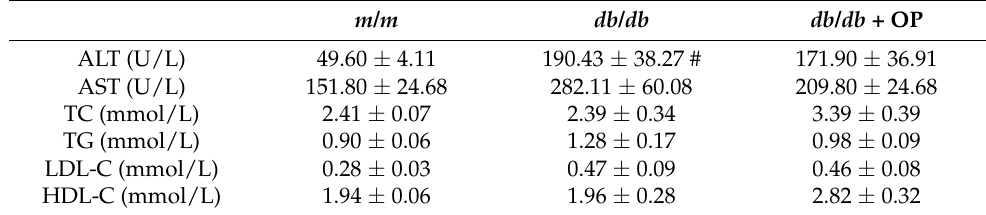
Table 2. The effects of OP on blood lipid profiles and liver function indicators of db / db